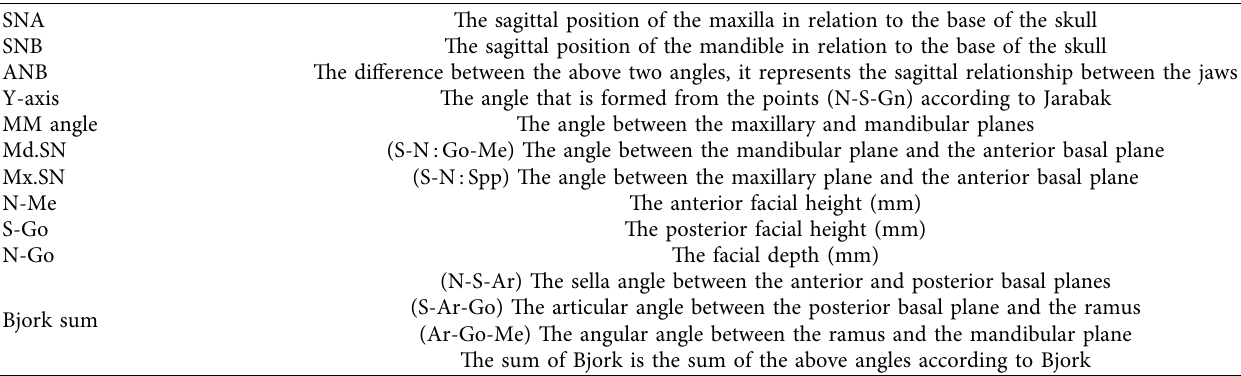
Table 1: The linear and angular measurements measured on the CBCT-derived cephalometric images ∗ .